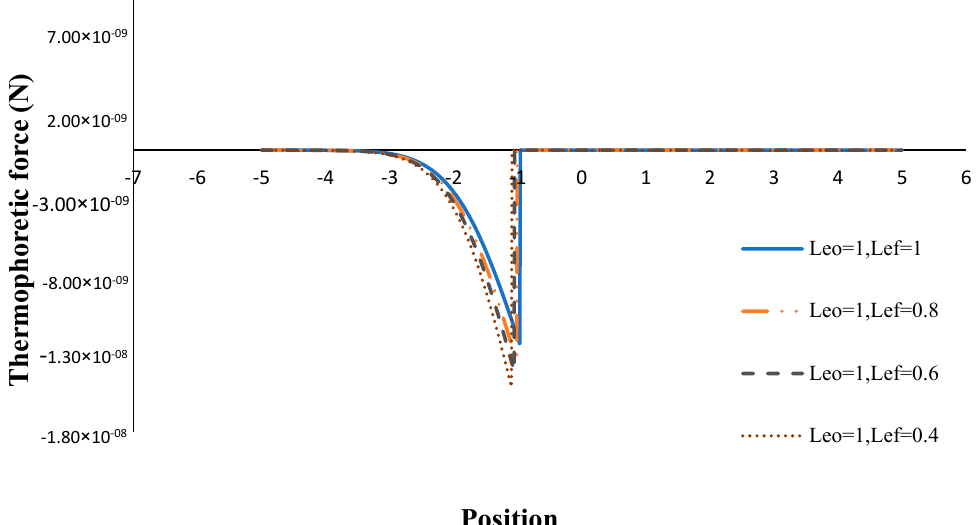
Figure 16. Thermophoretic force against position for different fuel Lewis numbers.